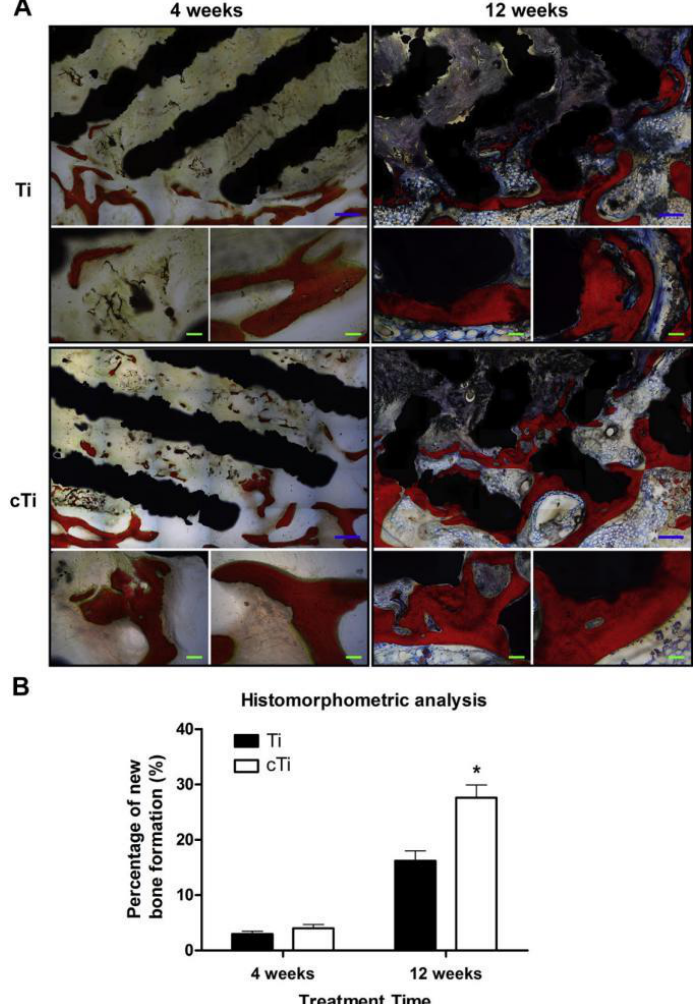
Figure 3. Histological examination of osteointegration at 4 and 12 weeks after implantation. ( A ) Van Gieson staining. The tissue stained in red color: the newly formed bone with visible cell nucleus. The tissue stained in dark blue color: fibrous tissue. ( B ) Histomorphometric measurement of new bone formation within the implants. (* p < 0.05) [129].